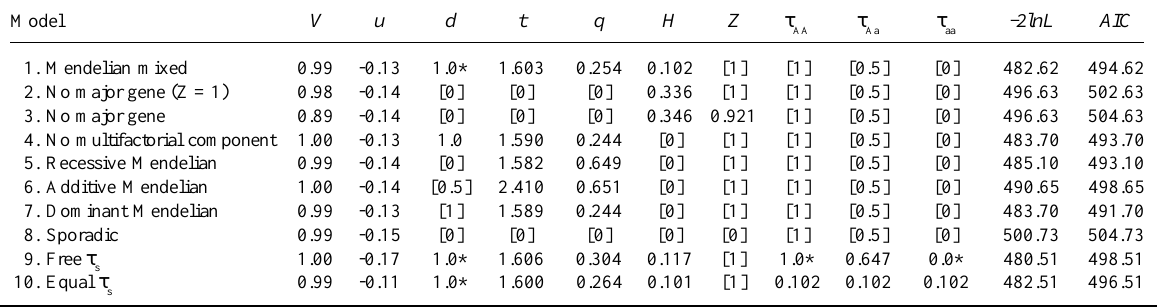
Table V - Segregation analysis of eosinophil levels among parasitized individuals, after correction for skewness (P = -1.925).